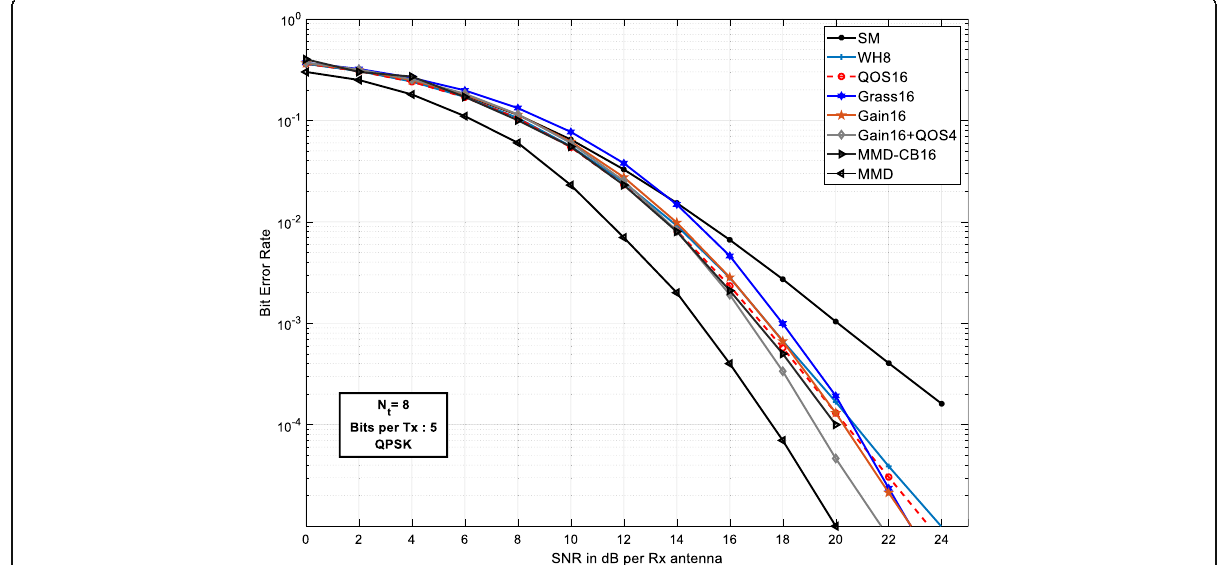
Fig. 4 BER performance and comparisons of proposed codebook precoding for SM with N t = 8 and N r =